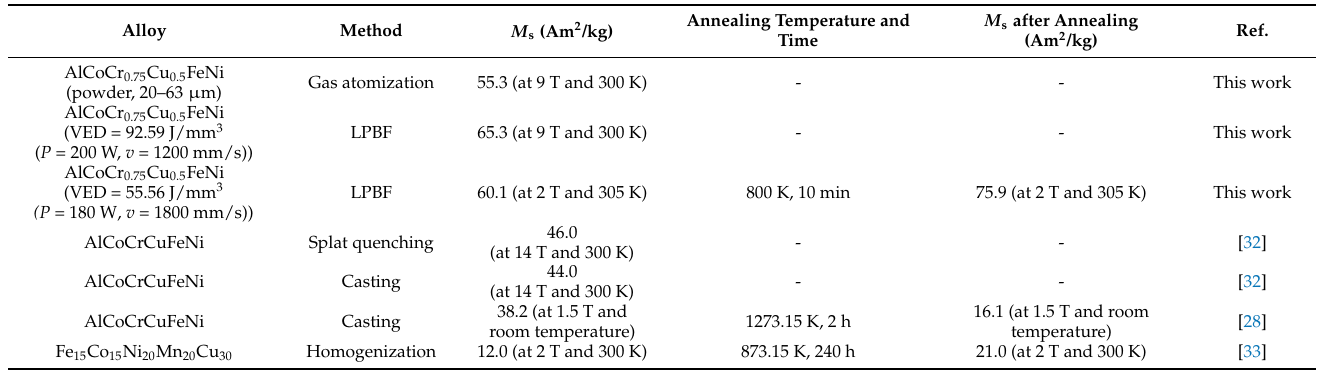
Table 5. The saturation magnetization of multicomponent alloys produced by various